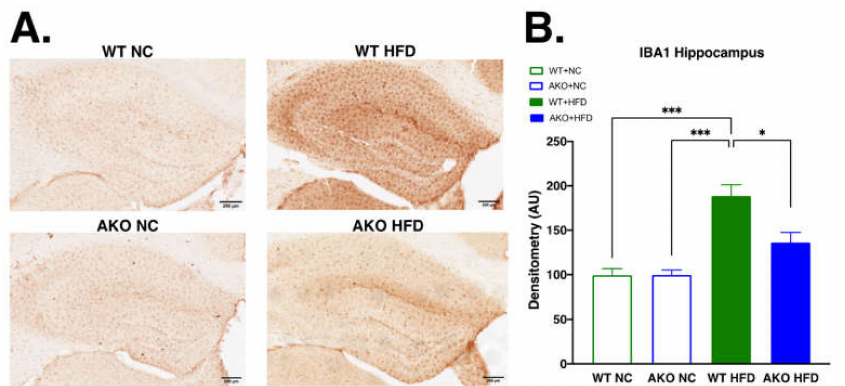
Figure 5. Loss of FABP4 leads to decrease in hippocampal IBA1 expression in mice fed HFD. ( A ) Hippocampal IBA1 stain of WT and AKO mice fed NC or HFD 40X magnification. Scale bar represents 200 µ m. ( B ) HFD-fed WT mice had increased hippocampal IBA1 expression compared to NC-fed mice ( p < 0.001). HFD-fed AKO mice had decreased hippocampal IBA1 expression compared to HFD-fed WT mice ( p < 0.02). n = 4–5. Data analyzed via one-way ANOVA and Tukey’s post-test. * p < 0.05, *** p < 0.001.